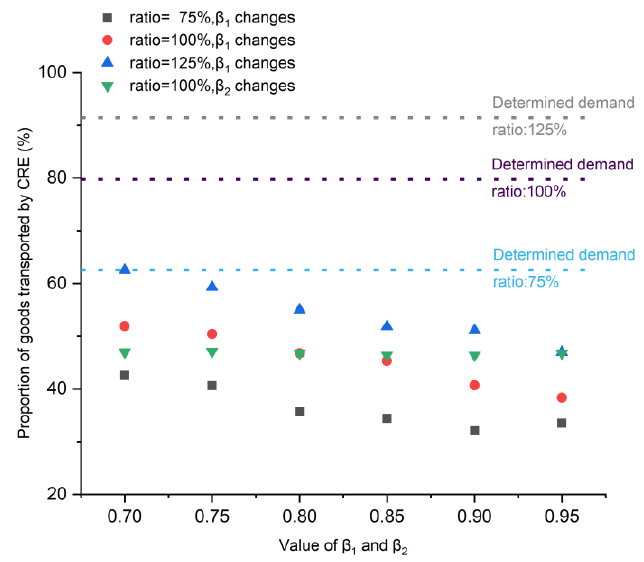
Figure 12. Changes in proportion of goods transported by CRE when β 1 , β 2 , and capacity of inland ports changes. Table 5. Computational results in Plan A to Plan